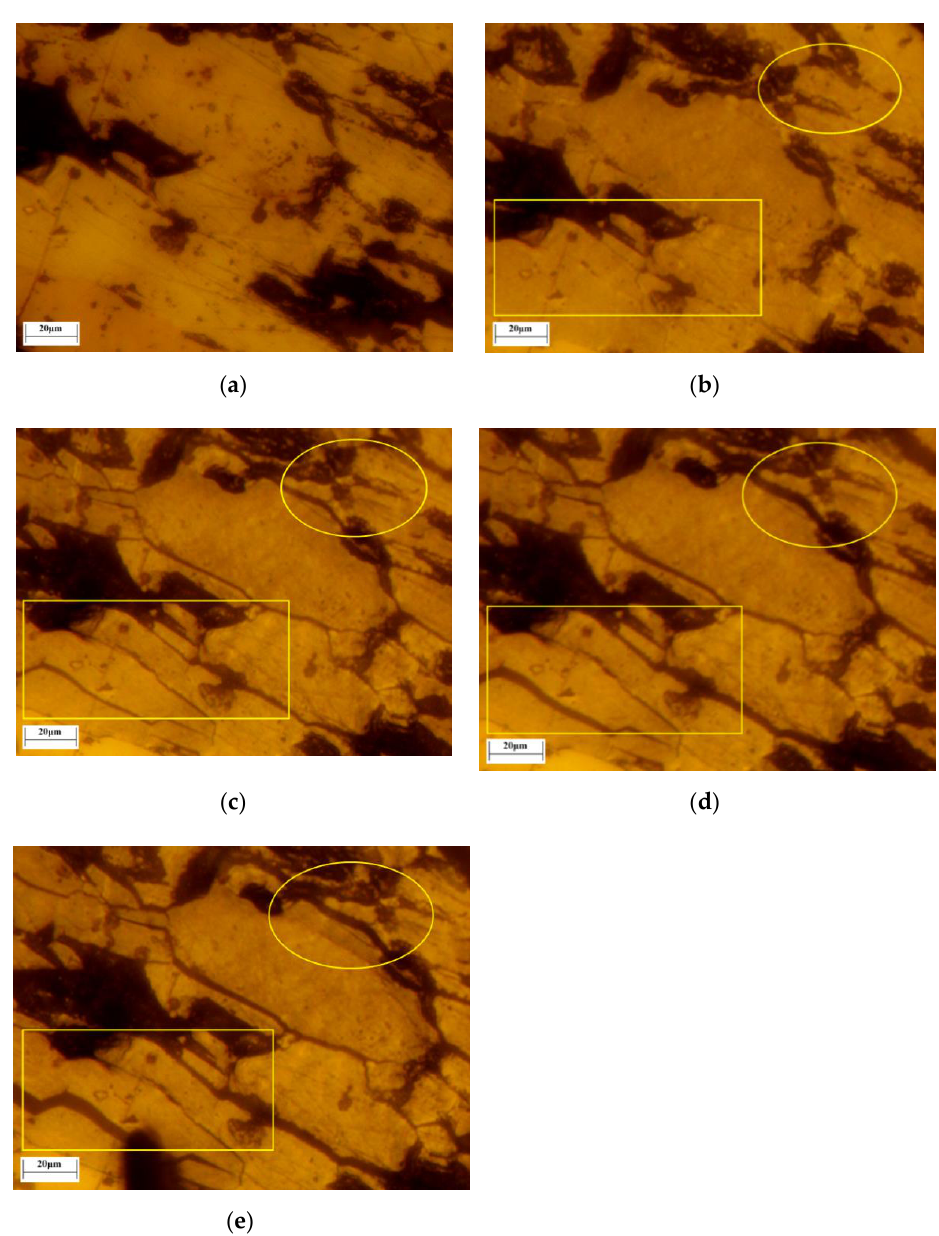
Figure 15. The continuous magnetization roasting process of single hematite. ( a ) 500 ℃ ; 0 s, ( b ) 500 ℃ ; 64 s, ( c ) 500 ℃ ; 114 s, ( d ) 500 ℃ ; 206 s, ( e ) 500 ℃ ; 326 s.